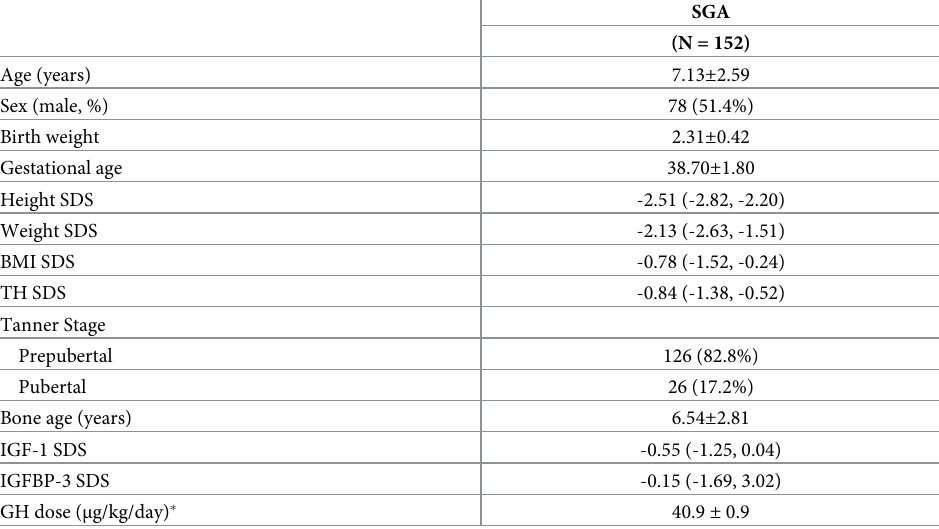
Table 1. Baseline characteristics in patients born SGA without catch-up